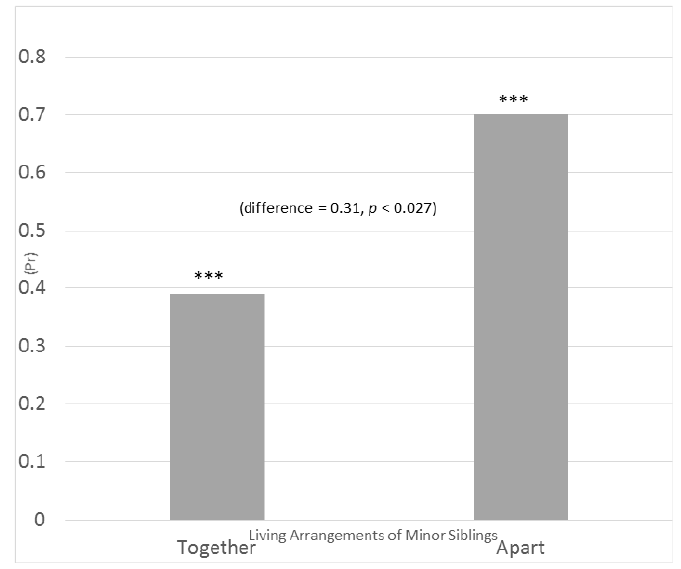
Figure 1. Predicted probability of high maternal role strain during incarceration. Note: Estimates include controls for maternal and child demographic characteristics, with these measures held at their mean values. Table 3. Logistic regression of maternal role strains on siblings living apart during maternal incarceration net of maternal and child